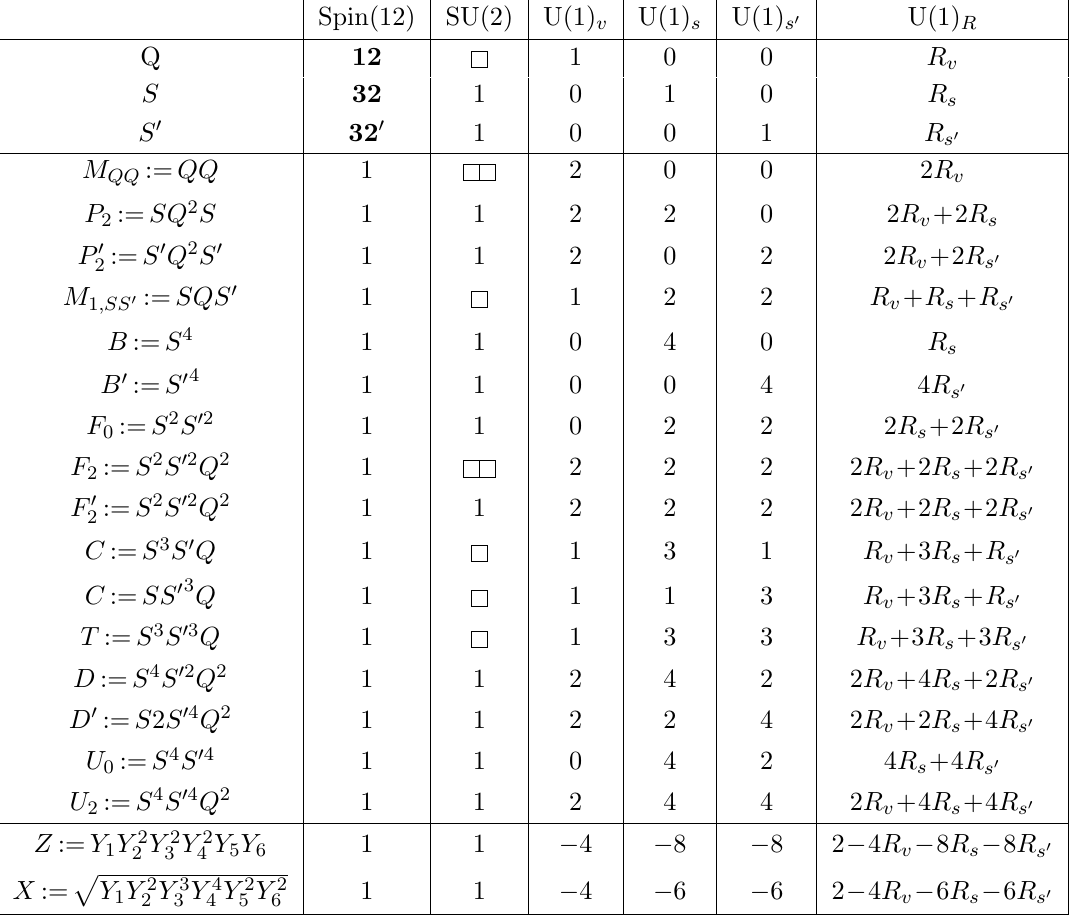
Table 22 . 3d N = 2 Spin(12) theory with ( N v ; N s ; N s 0 ) = (2 ; 1 ;